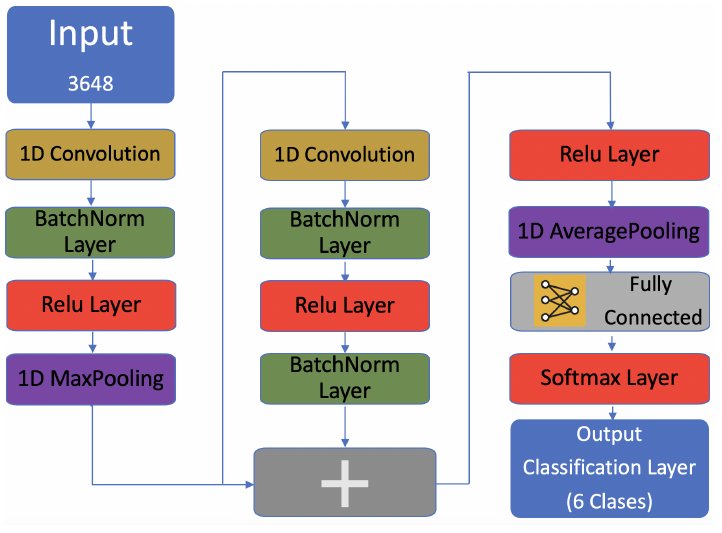
Figure 3. ResNet architecture.